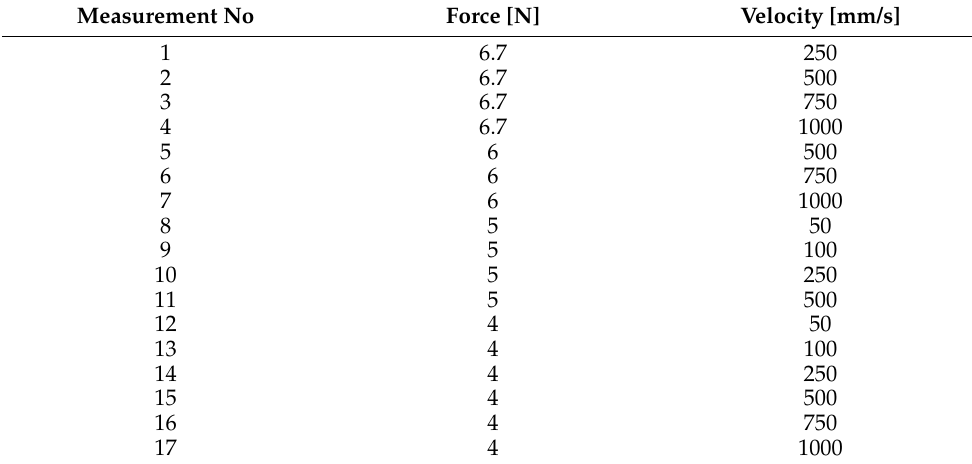
Table 1. Selected values of process parameters.